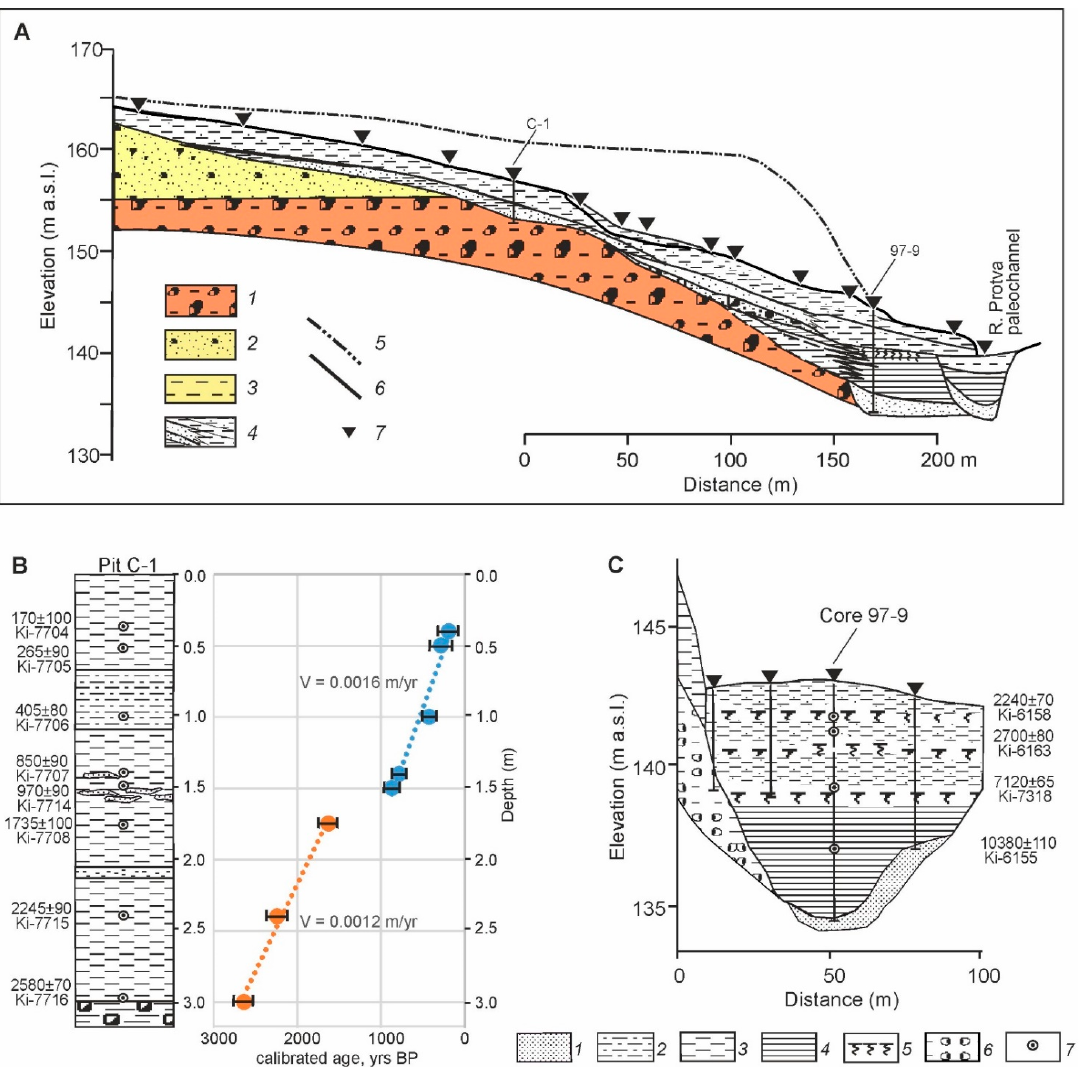
Figure 8. The longitudinal profile of the Senokosniy Gully. Keys for the profile ( A ): 1—MIS 6 moraine, 2—glaciofluvial sand with gravel, 3—lacustrine silt, 4—Holocene deposits (sand and loam), 5—initial slope, 6—gully bed, 7—cross-sections. Keys for the pit ( B ) and core ( C ): 1—sand, 2—sandy loam, 3—loam, 4—clay, 5—buried soil, 7— 14 C samples.